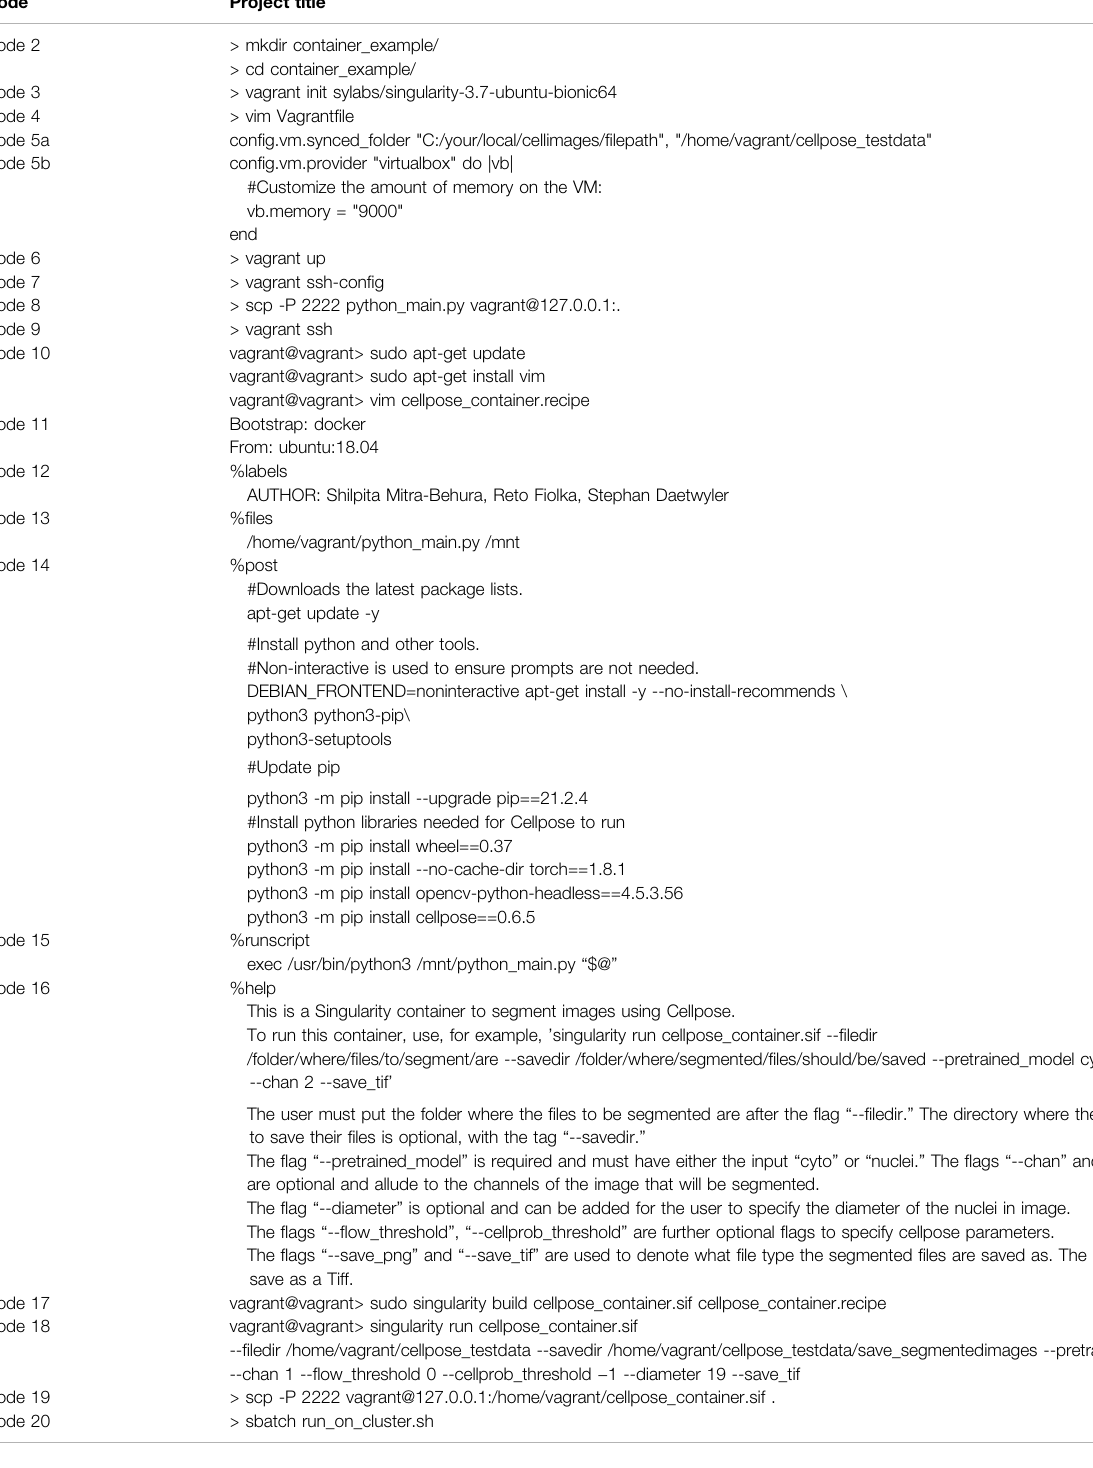
TABLE1| Codeusedinthestep-by-step protocolforestablishingacontainerusingade fi nition fi le.Pleasenotethatcopying somecodedirectlyfromthetablemightinduce errors due to formatting. Hence, we suggest to type the commands newly in case of errors, and refer to the fi les on github: https://github.com/DaetwylerStephan/ Containerize_ImageAnalysis or in the Supplementary Material